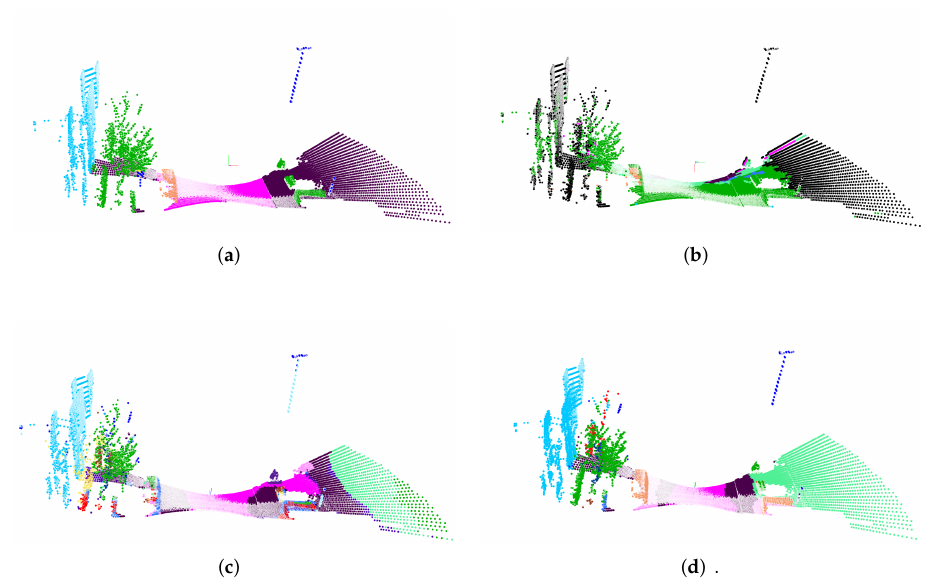
Figure 9. Results on ParisLille data. Using the best-performing single projection approach ends up in a very poor performance ( b ). The bird’s-eye projections are generally far better but are still worse than on the trained data. ( a ) Ground truth; ( b ) Prediction sphere; ( c ) Prediction bird’s-eye; ( d ) Prediction 3D bird’s-eye.